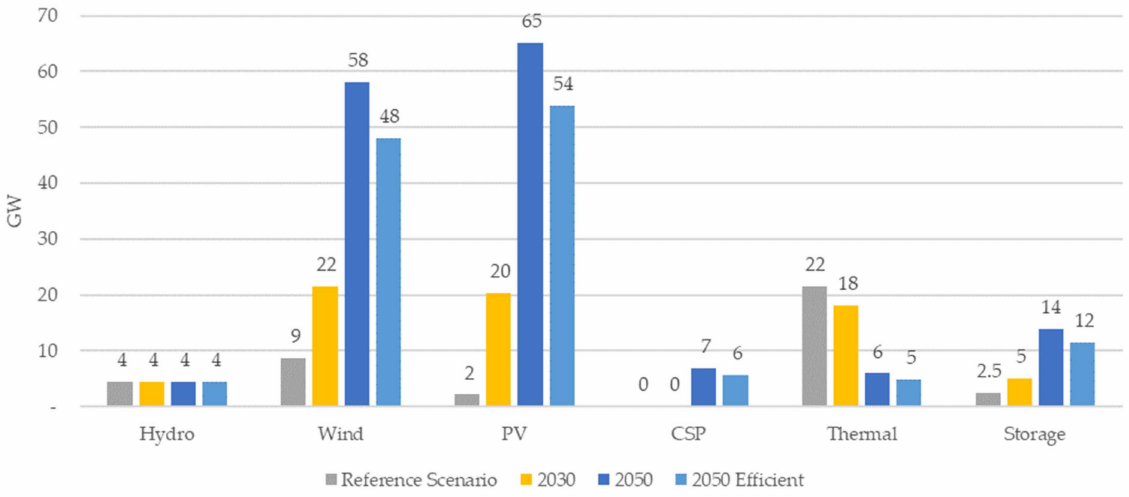
Figure 5. Power capacity in the Bioregion for the electricity system.